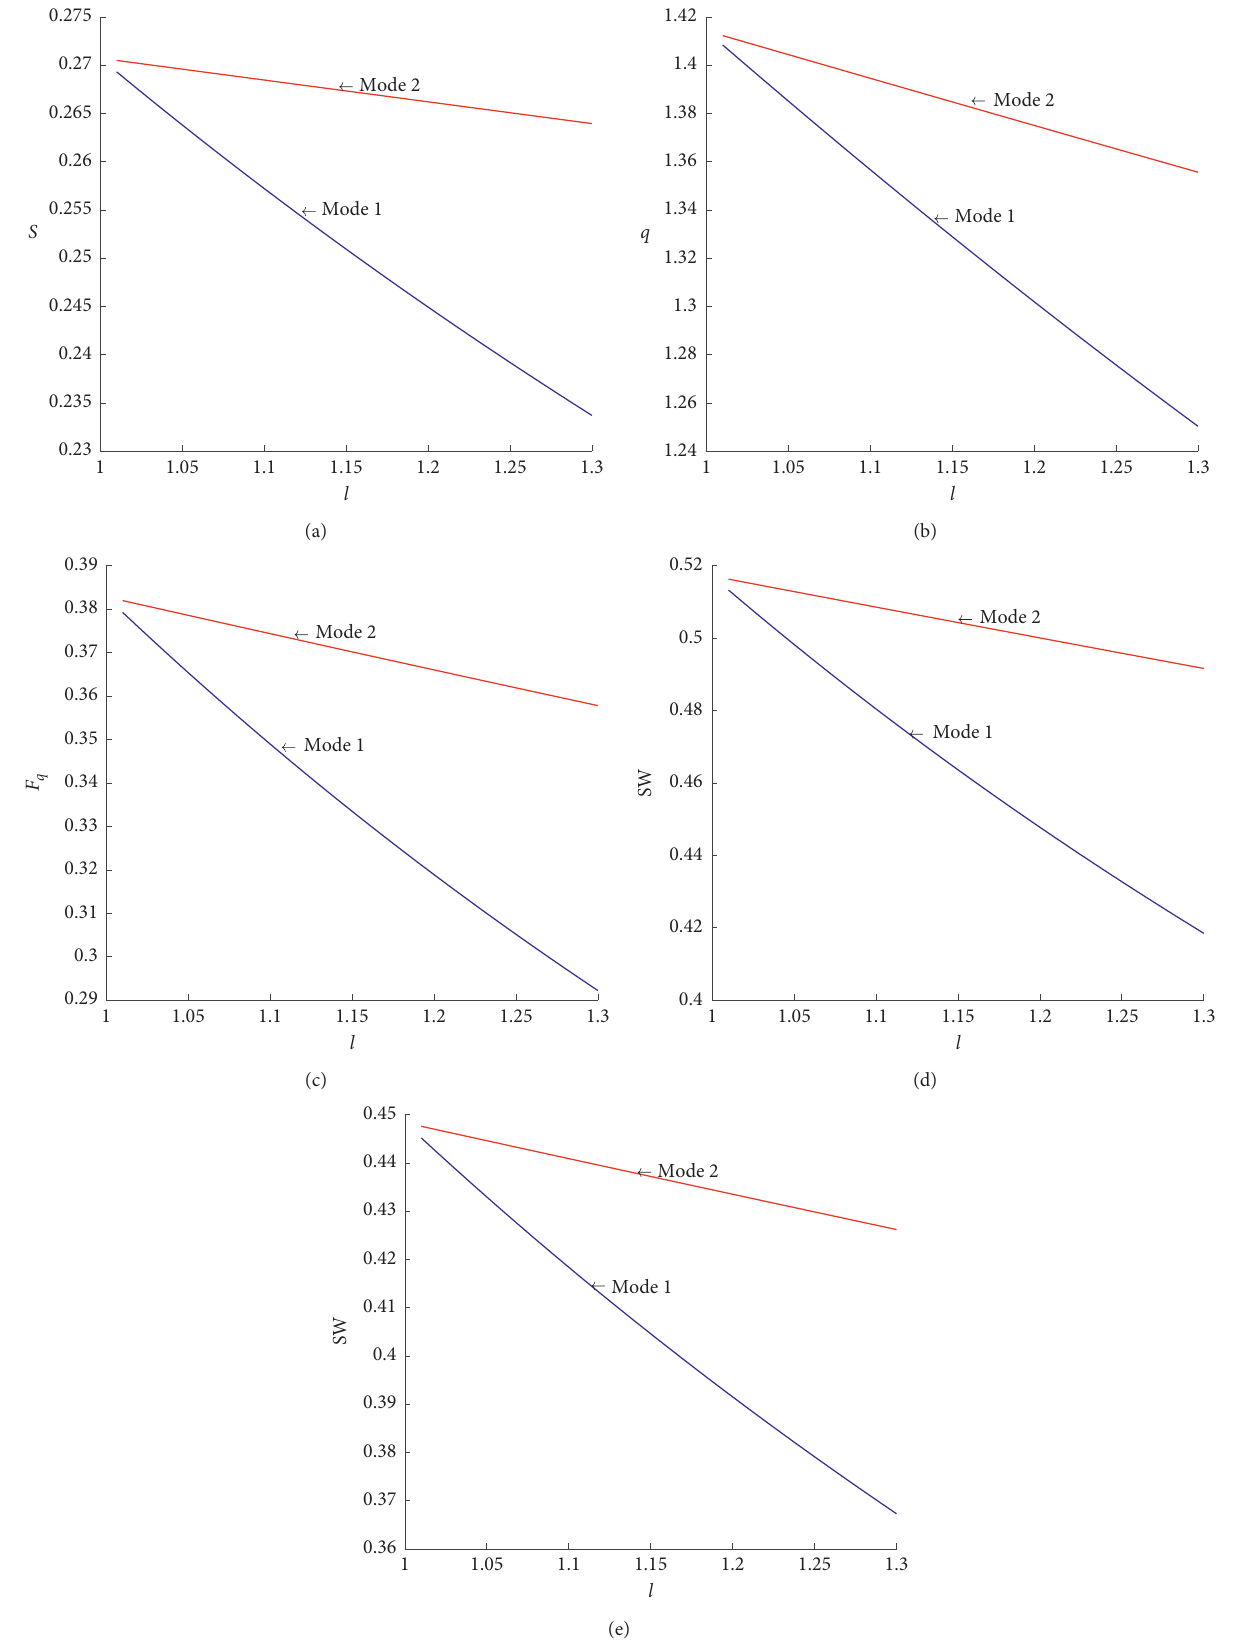
Figure 7: (a) The unit government subsidy as l changes. (b) The safety investment as l changes. (c) The government expenditure as l changes. (d) The social welfare as l changes when the government decides the subsidy. (e) The social welfare as l changes when S �